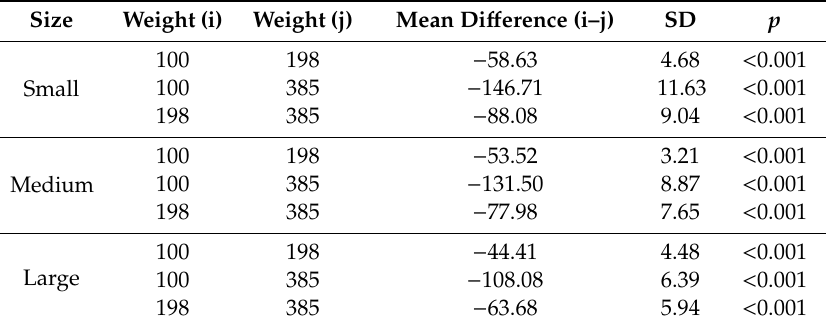
Table 5. Perceived weight comparison of three cookie box